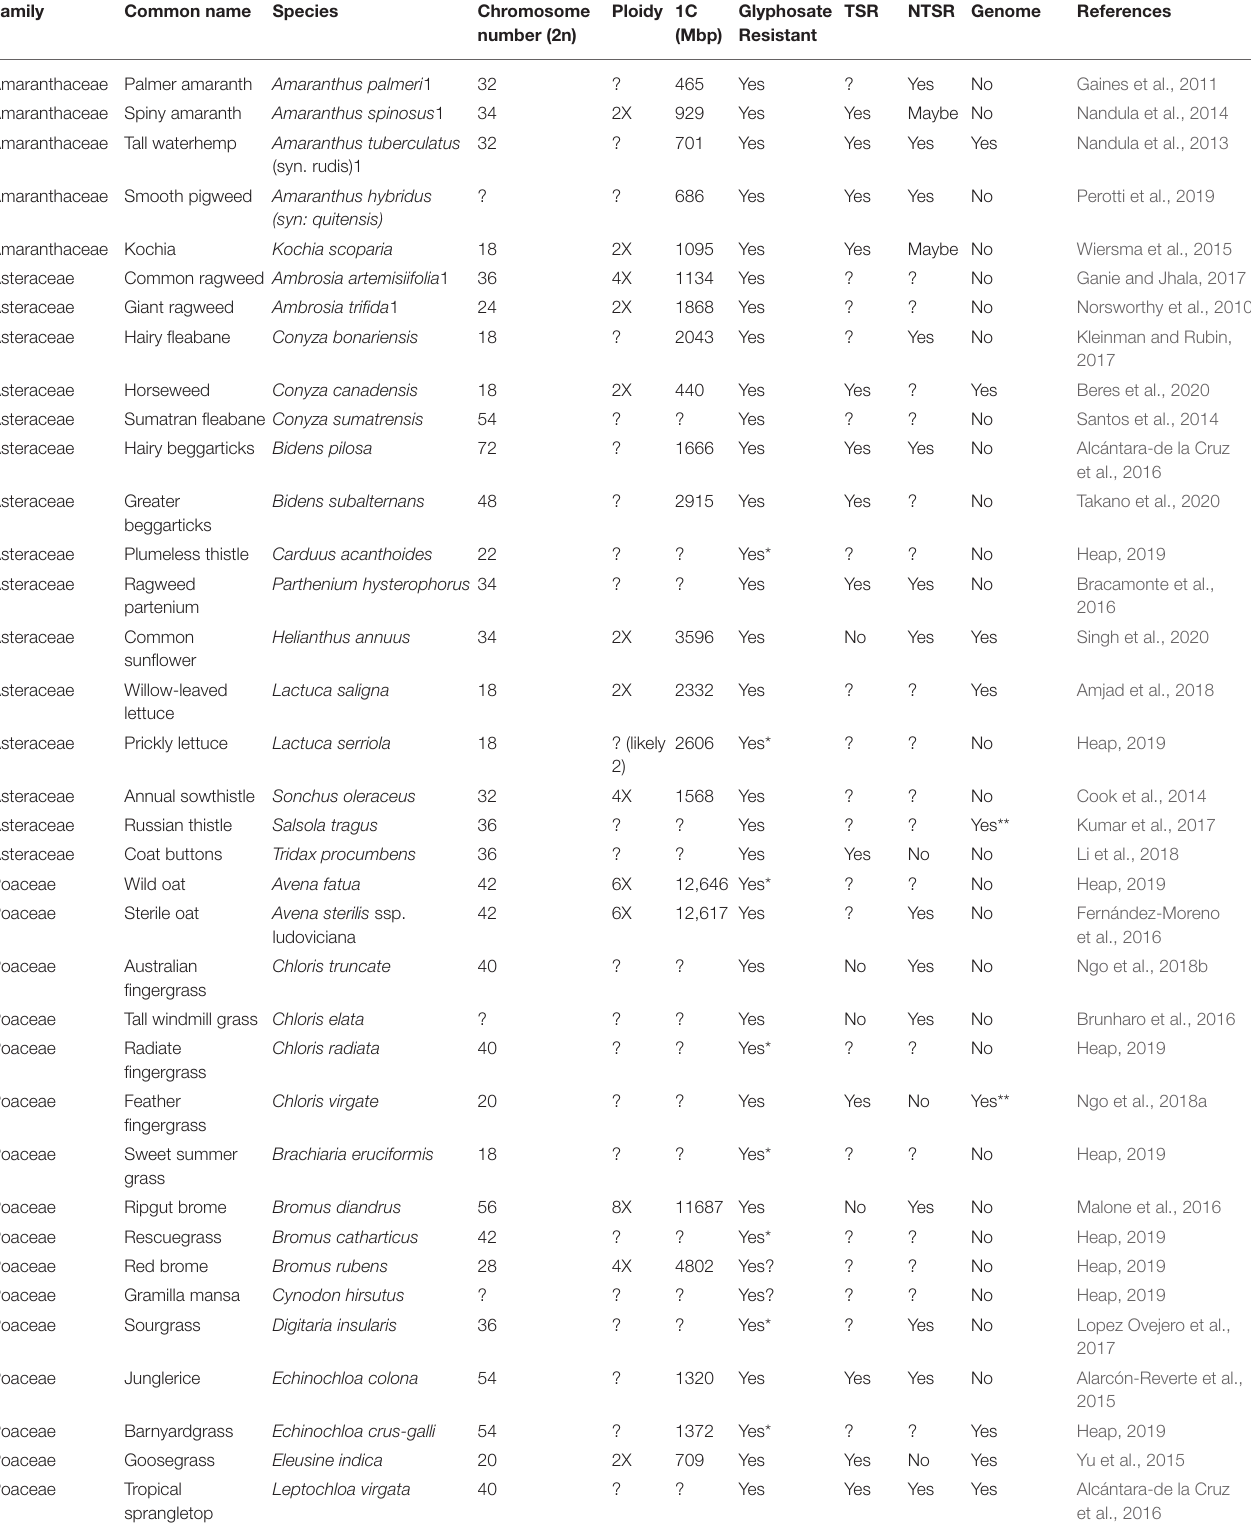
TABLE 2 | Weed species currently (9 June 2020) reported as resistant to glyphosate according to The International Survey of Herbicide Resistant Weeds and corresponding reported genomic data.